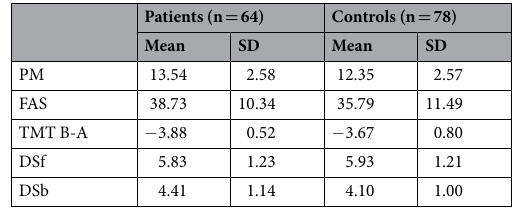
Table 2. Neuropsychological results. PM: Prose Memory test; FAS: phonemic fluency test; TMT B-A: trial making test, log-transformed difference between B and A subtests; DSf: digit span forwards; DSb: digit span backwards; SD: standard